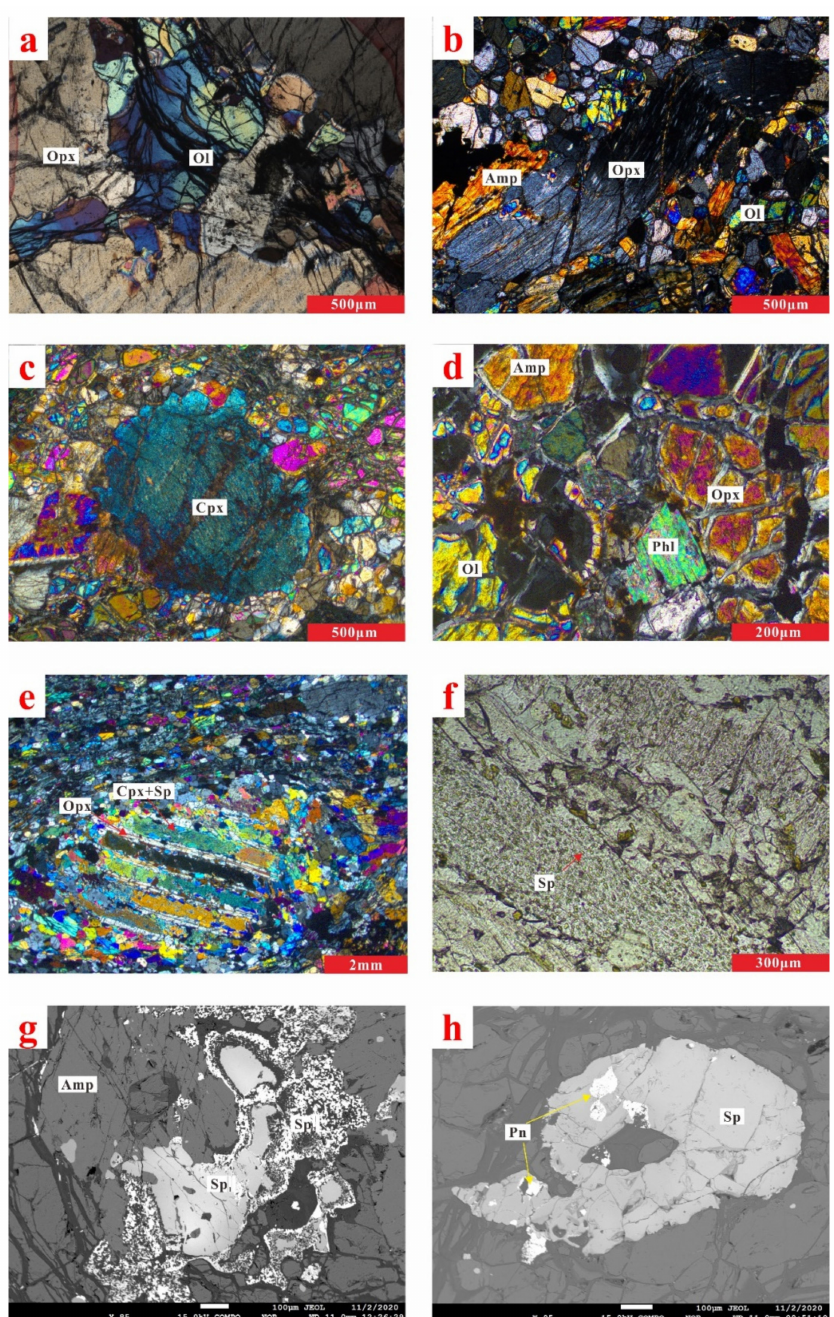
Figure 2. Photomicrographs and BSE images of the Raobazhai harzburgite samples. ( a ): olivine (Ol) with wavy extinction in phenocrystal orthopyroxene (Opx); ( b ): phenocrystal Opx with wavy extinction; ( c ): phenocrystal clinopyroxene (Cpx) with wavy extinction; ( d ): amphibole (Amp) and phlogopite (Phl) are commonly developed with perfect euhedral habit; ( e , f ): (RBZ-17) clinopyroxene and orthopyroxene occur interstratified, and spinel (Sp) occurs within the interstratified minerals as exsolution grains; ( g ): two stages of spinel are present; ( h ): pentlandite (Pn), a sulfide phase, is seen associated with